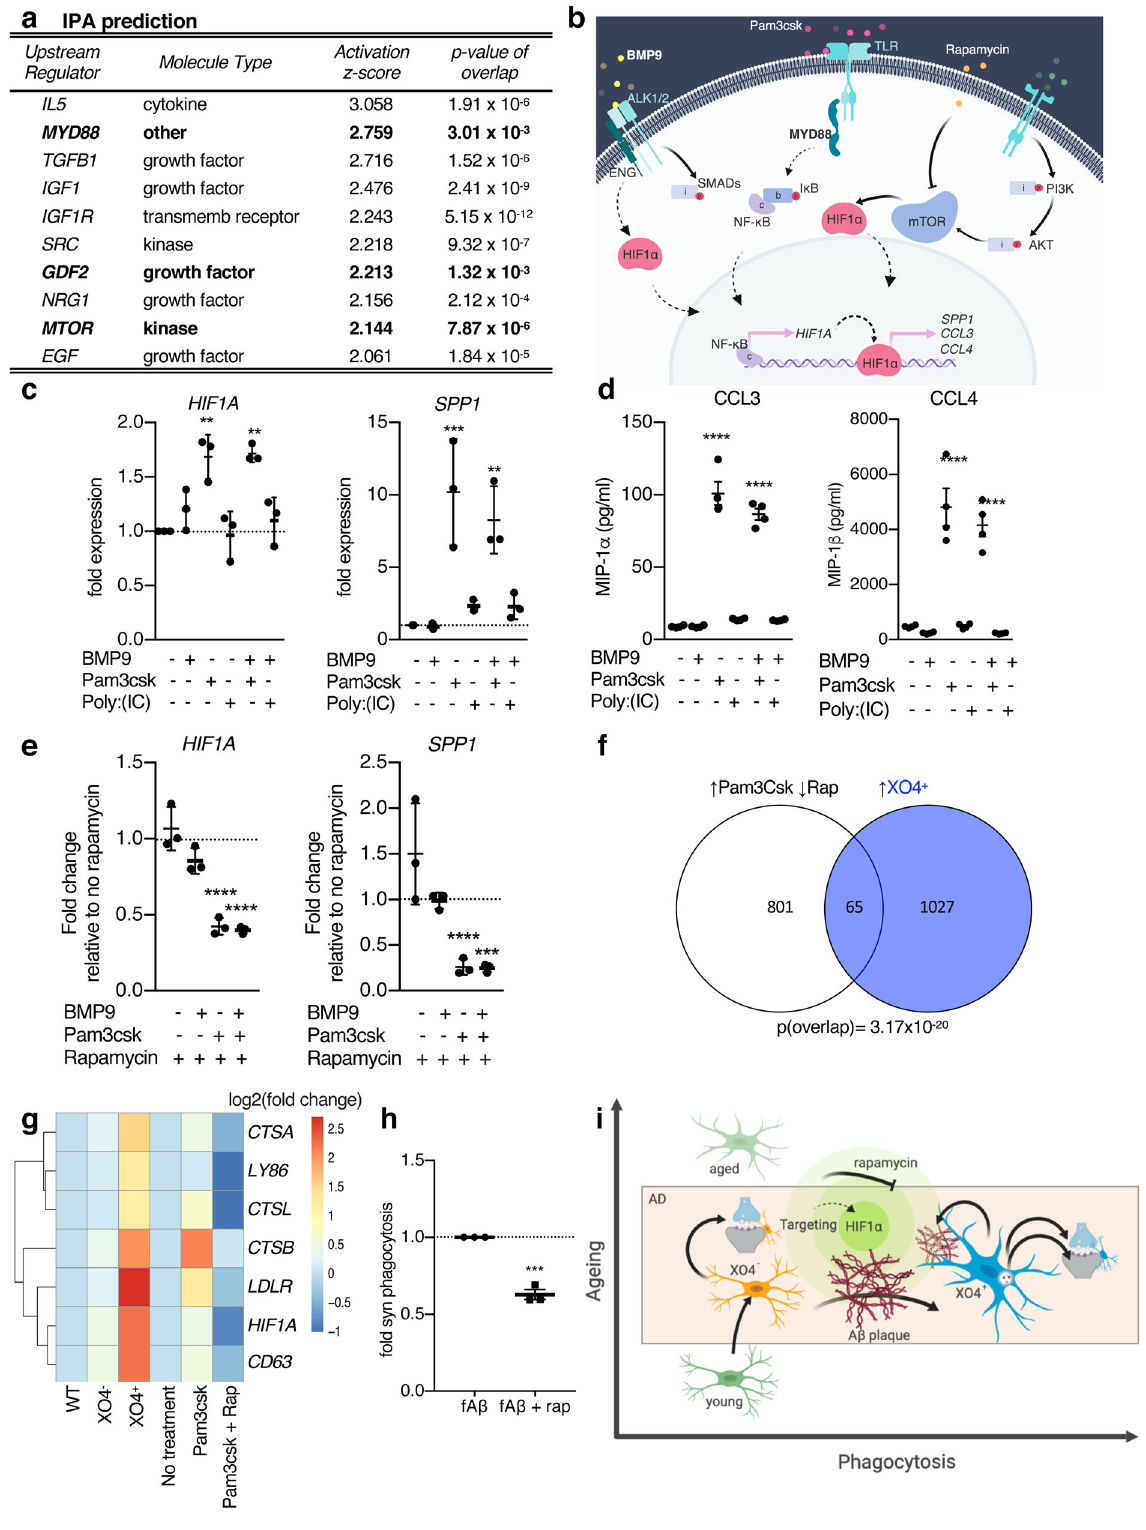
resulting in a gene expression signature associated with XO4 + microglia primes microglia for enhanced phagocytosis of synap- tosomes, although it is important to note that the ef fi ciency of individual phagocytic processes can be dependent on experi- mental conditions 65 – 67 . Rapid pruning of damaged synapses near dystrophic neurites localized around plaques appears to be, at least initially, protective and may go awry later in